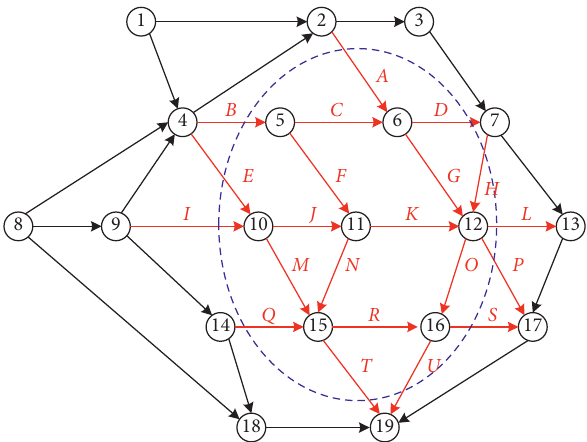
Figure 6: Layout of the testing road network.